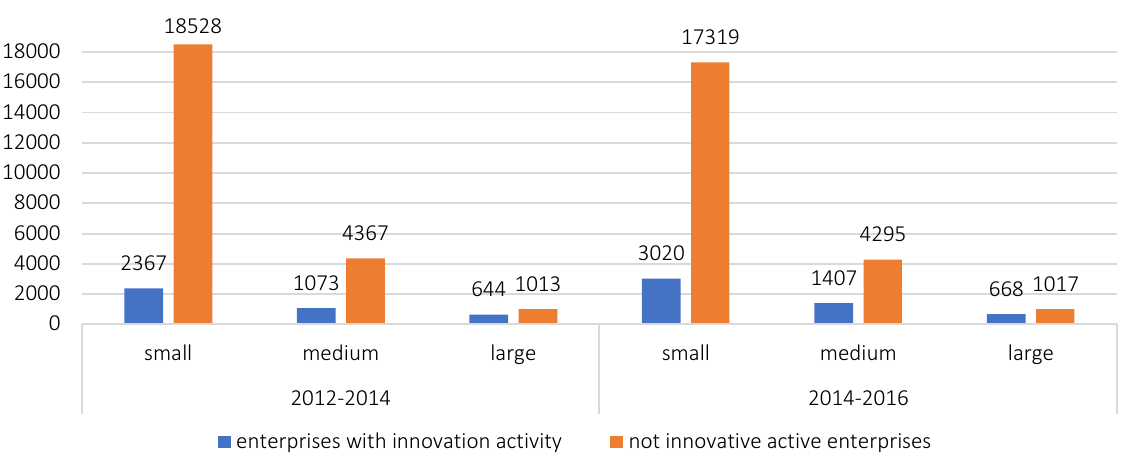
Figure 3. Ukrainian enterprises by types of innovation activities, % Source: Formed by the authors based on data of State Statistics Service of